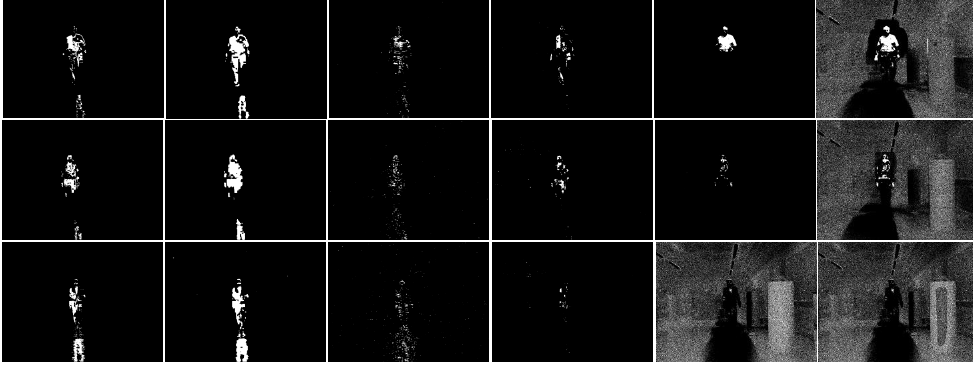
Figure 7. Moving object detection in indoor high light scene ( Row 1: Object 1, Row 2: Object 2, Row 3 : Object 3)